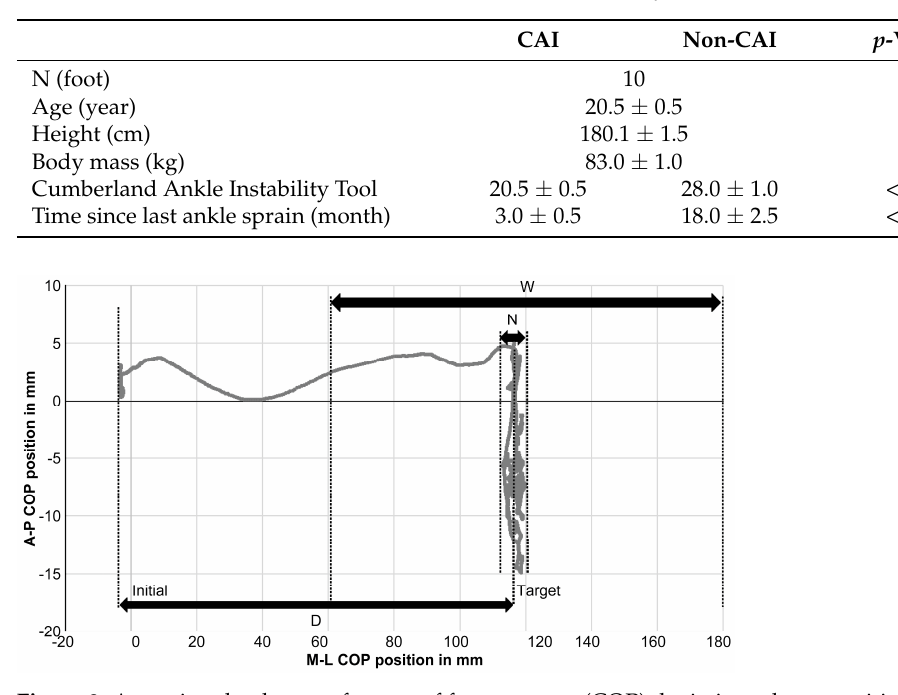
Figure 3. Assessing the degree of center of foot pressure (COP) deviation when transitioning from the initial position (DLS) to a less stable SLS target, using the Fitts’ model depicted in Figure 1 and Equation (1). The index of difficulty is determined by the distance ( D ) between the DLS and SLS equilibrium points, as well as the width of the target relative to the foot width ( W ).